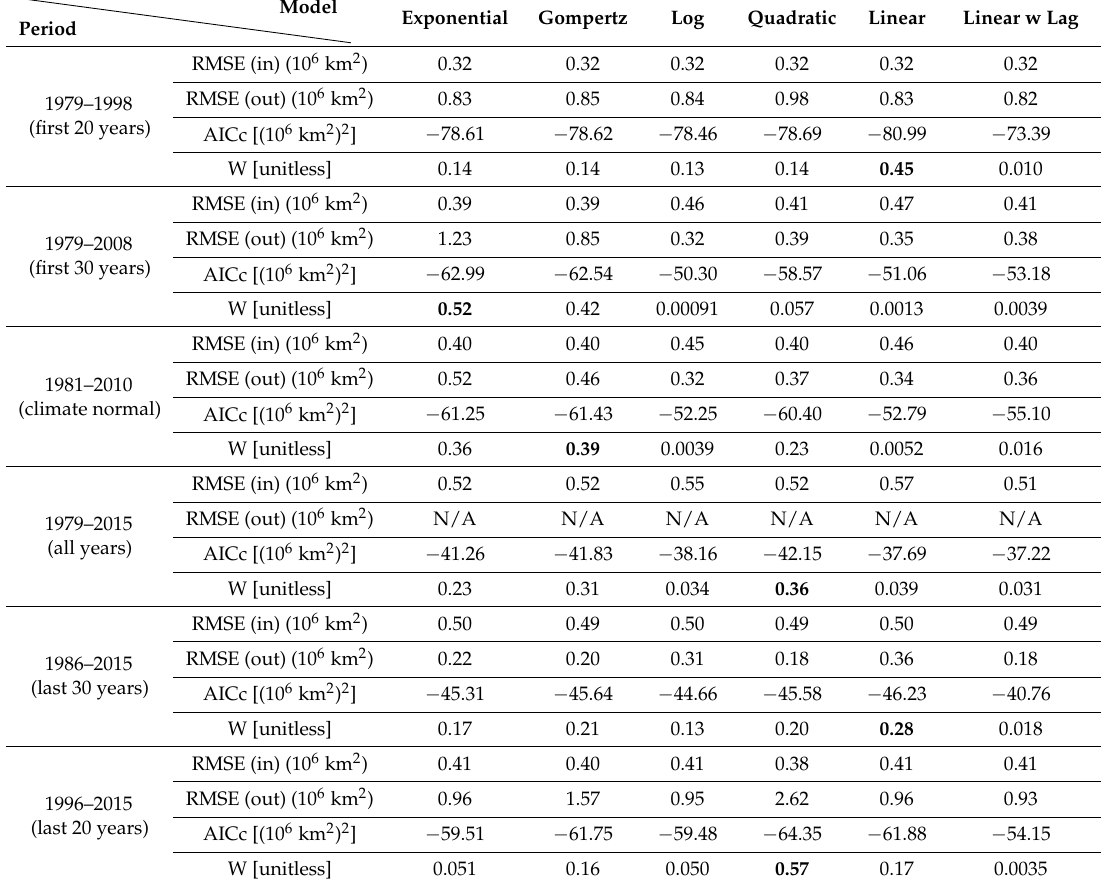
Table 3. Metrics from model optimization. Entries in bold indicate the best fit among the six models for the time period.